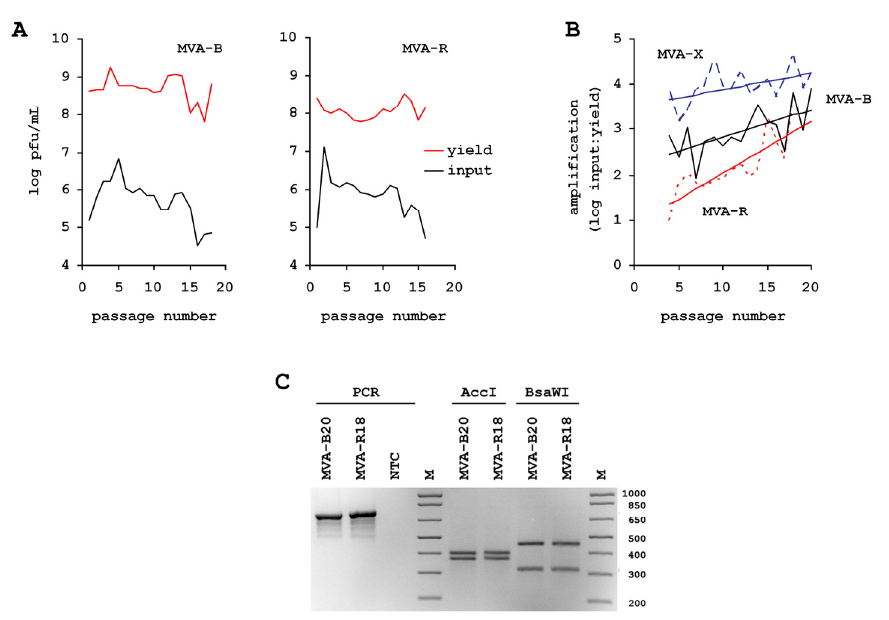
Figure 5. Consecutive passages of MVA on adherent serum-dependent CR.pIX cells and mammalian R05T cells. MVA-B is the lineage derived from the CR.pIX and MVA-R is the lineage derived from the R05T cells. ( A ) Sequential infection was performed without knowing the titer of the previous passage. The resulting fluctuations in input virus are shown in the lower (black) curve, the yield is shown in the upper (red) curve. Units are log of pfu/mL. Complete lysate for virus passaging was prepared from cultures with 10 pronounced cytopathic effect, 48 h to 72 h post infection in CR.pIX cultures and 72 h to 96 h post infection in R05T cultures. Virus was released by sonication. ( B ) Dividing yield by input virus describes amplification of virus for each passage. MVA-X (broken blue curve) is the lineage that was derived from the suspension culture in chemically-defined medium shown in Figure 1. ( C ) No emergence of the D86Y A34R phenotype in MVA populations passaged on adherent cells. Compare to Figure 1D for restriction fragment length polymorphism where the D86Y genotype in A34R accumulates. Maintenance of wild type sequence in the complete genes A3L, A9L and A34R was also confirmed by conventional sequencing, with the relevant region shown for MVA-B20 in Figure